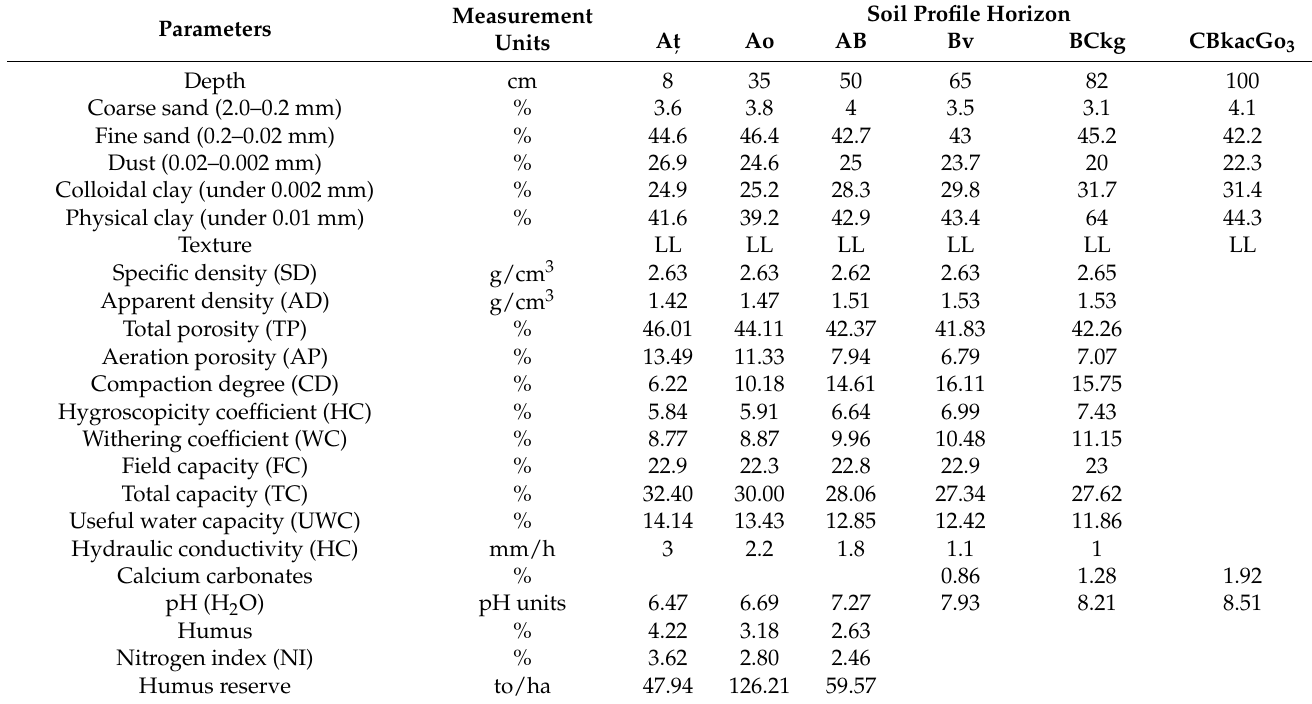
Table 3. Values of physical, hydrophysical, and chemical parameters for the description of the soil profile SP1, pasture plot P808, Ciacova, Timis County, Romania.